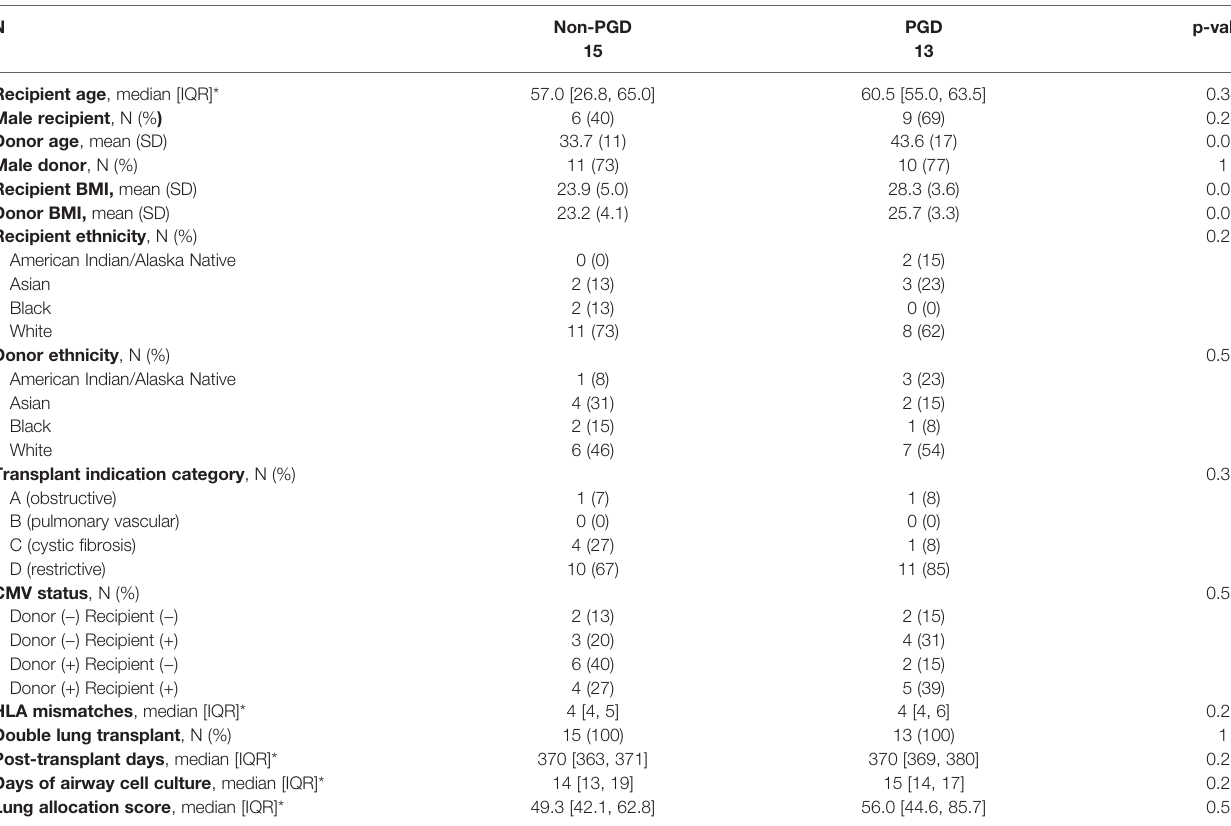
TABLE 1 | Subject characteristics.